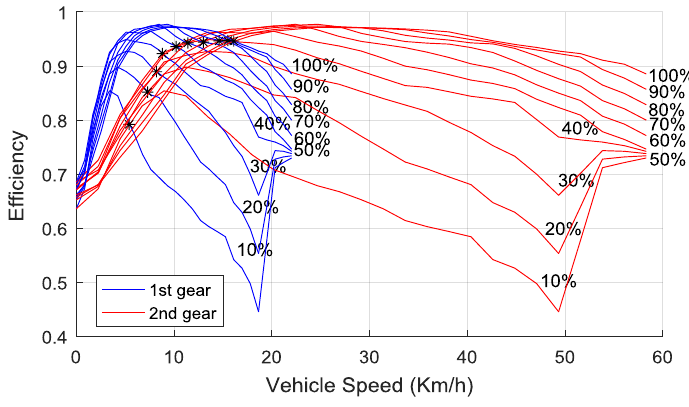
Figure 7. Efficiency curves on different pedal positions.